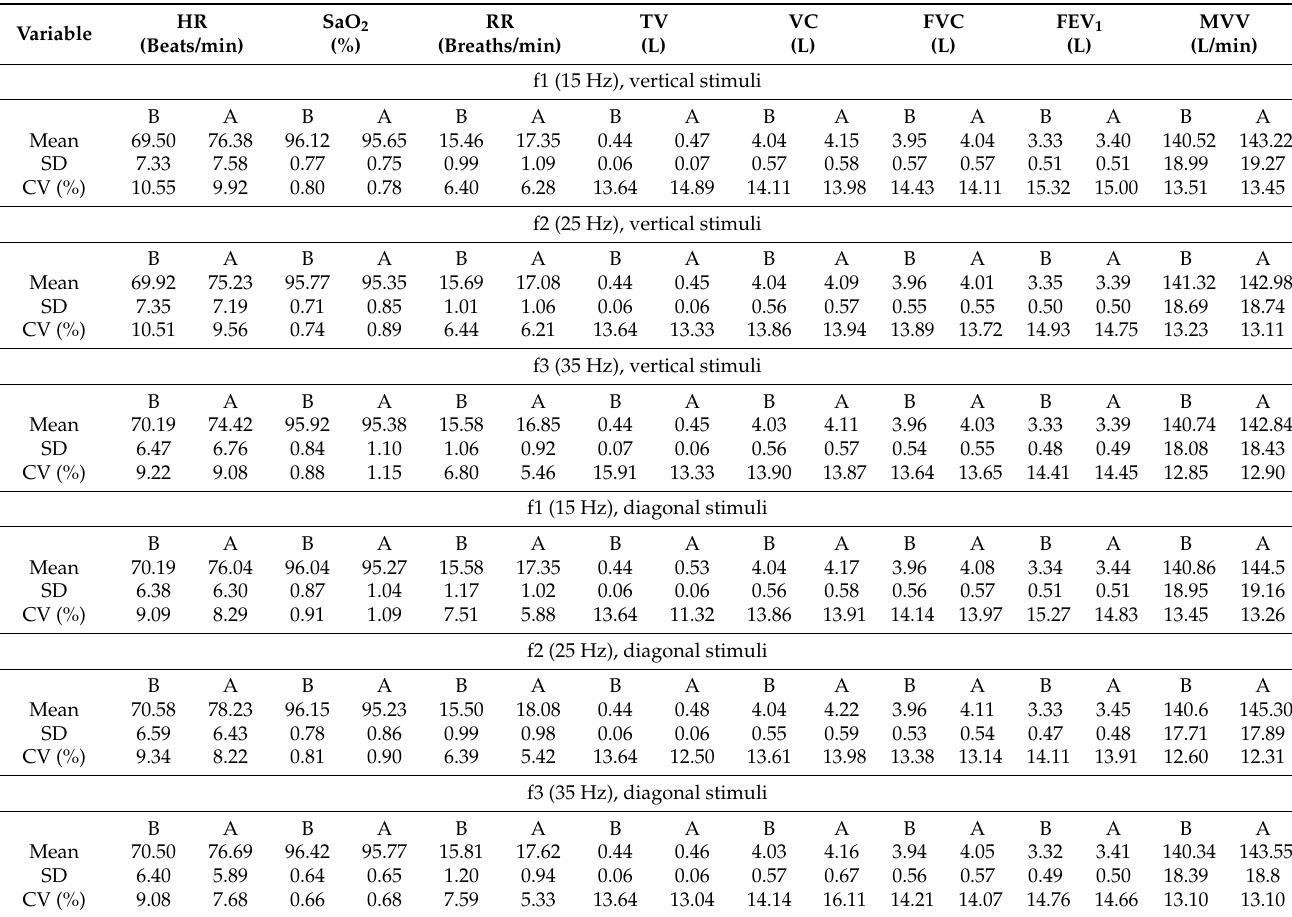
Table 2. Statistic indicators for investigated parameters in the experimental group ( n = 26).